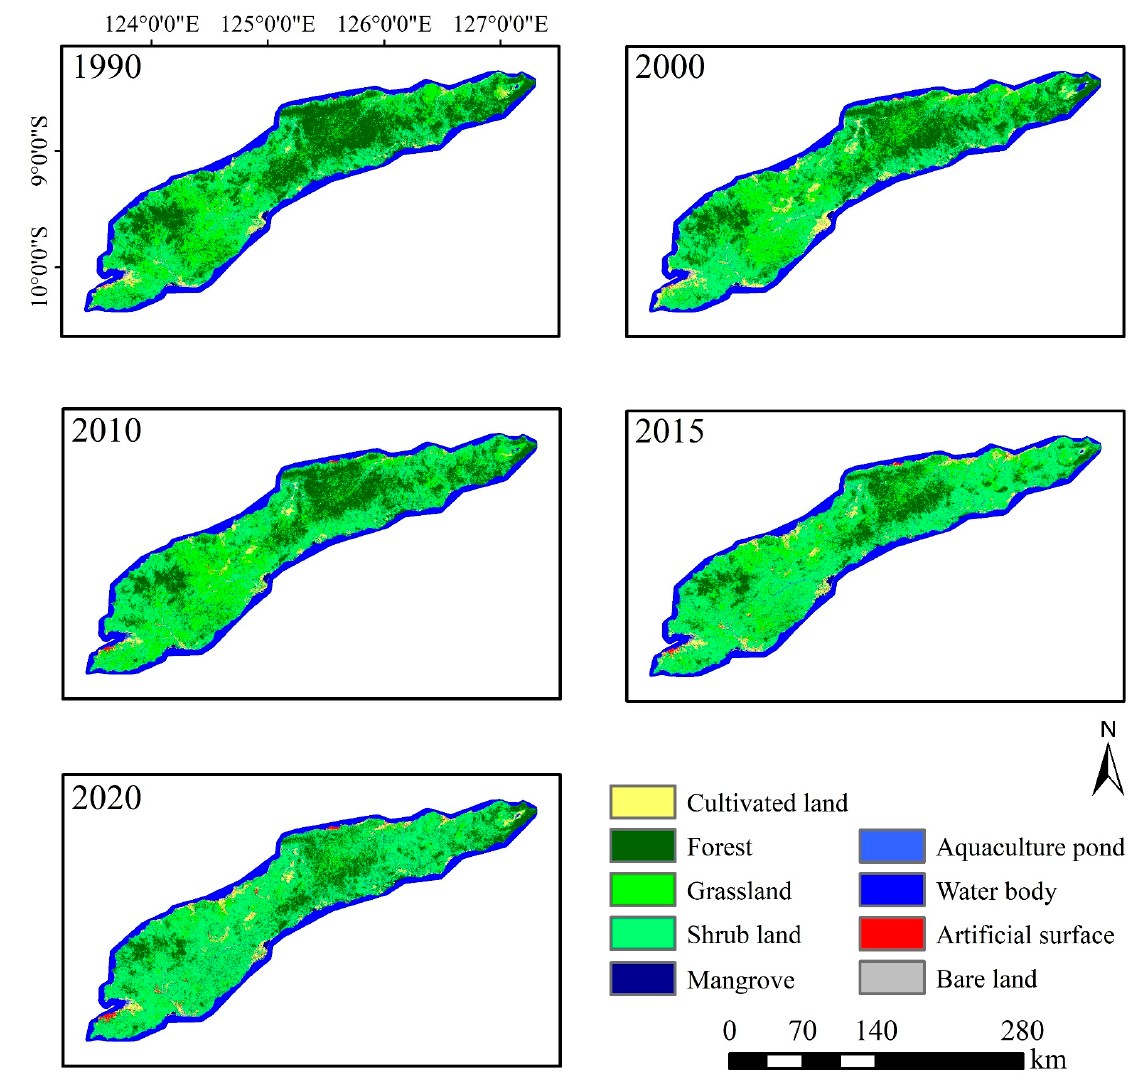
Figure 4. Spatial distribution of land cover in Timor from 1990 to 2020.